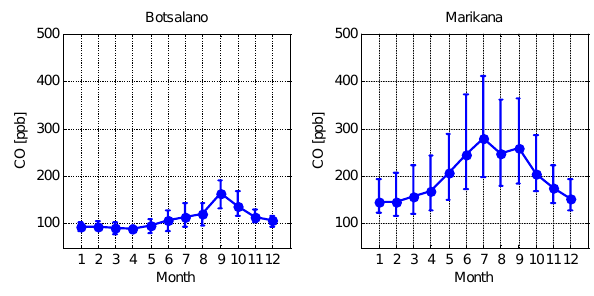
Fig. 9. Monthly median concentrations of CO for Botsalano and Marikana. Error bars indicate the upper and lower